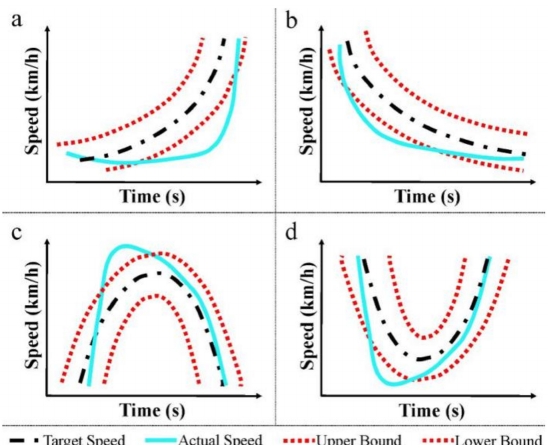
Figure 6. The schematic diagram of four types of faults: ( a ) Acceleration fault; ( b ) Deceleration fault; ( c ) Convex fault; and ( d ) Concave